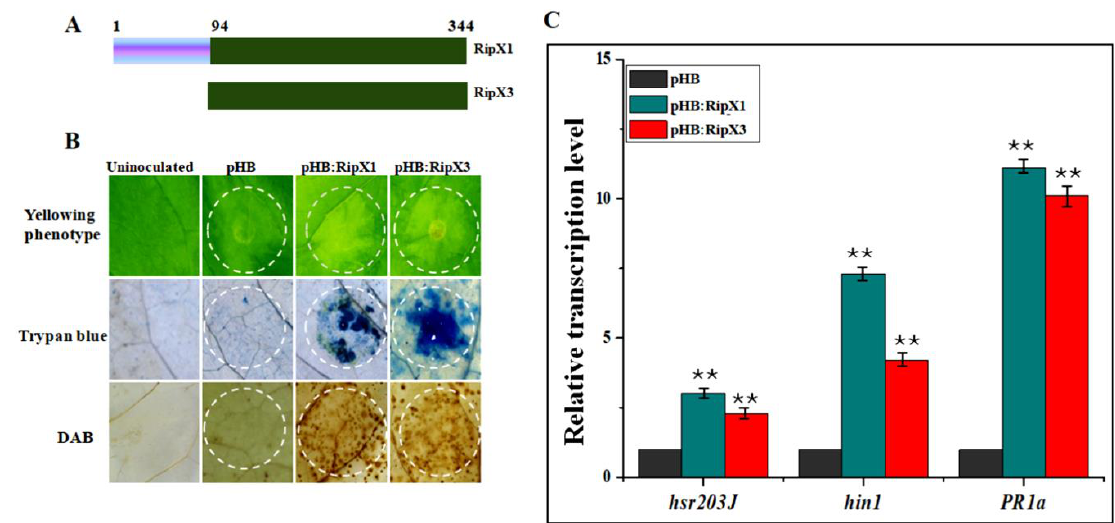
Figure 1. Defense reaction induced by transient expression of ripX1 and ripX3 in Nicotiana benthamiana . ( A ) Schematic diagram of expressed RipX1 and RipX3. ( B ) Yellowing phenotypes induced by RipX1 and RipX3. The infiltration areas were indicated by circles. All the experiments were repeated three times. ( C ) Activation of the defense genes hsr203J , hin1 , and PR1a . The transcript level of each gene in plants transformed with empty vector pHB was set to 1, and levels in other plant samples were calculated relative to that. Data represent mean and standard deviation of three technical replicates. The asterisks denote statistical significance (** p ˂ 0.01).